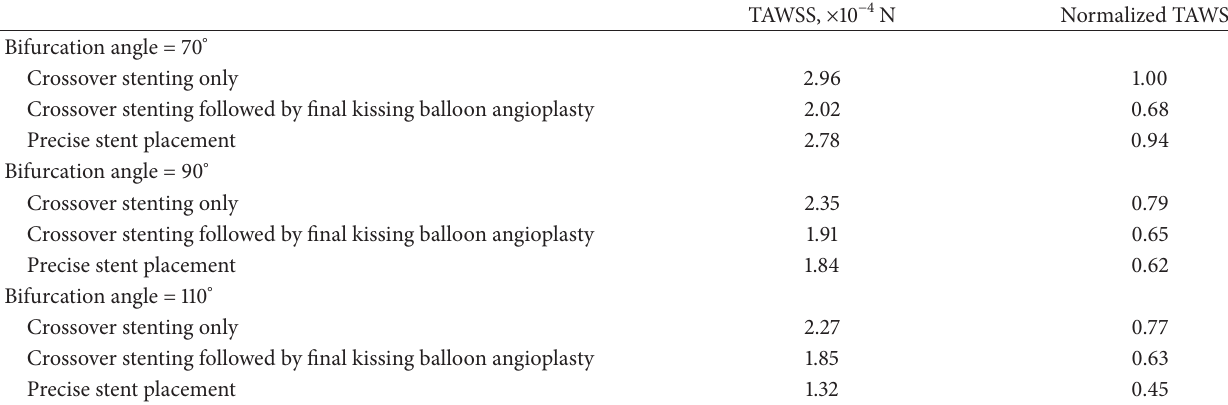
Table 1: Surface integrals of TAWSS for considered stenting techniques under different bifurcation angle conditions.